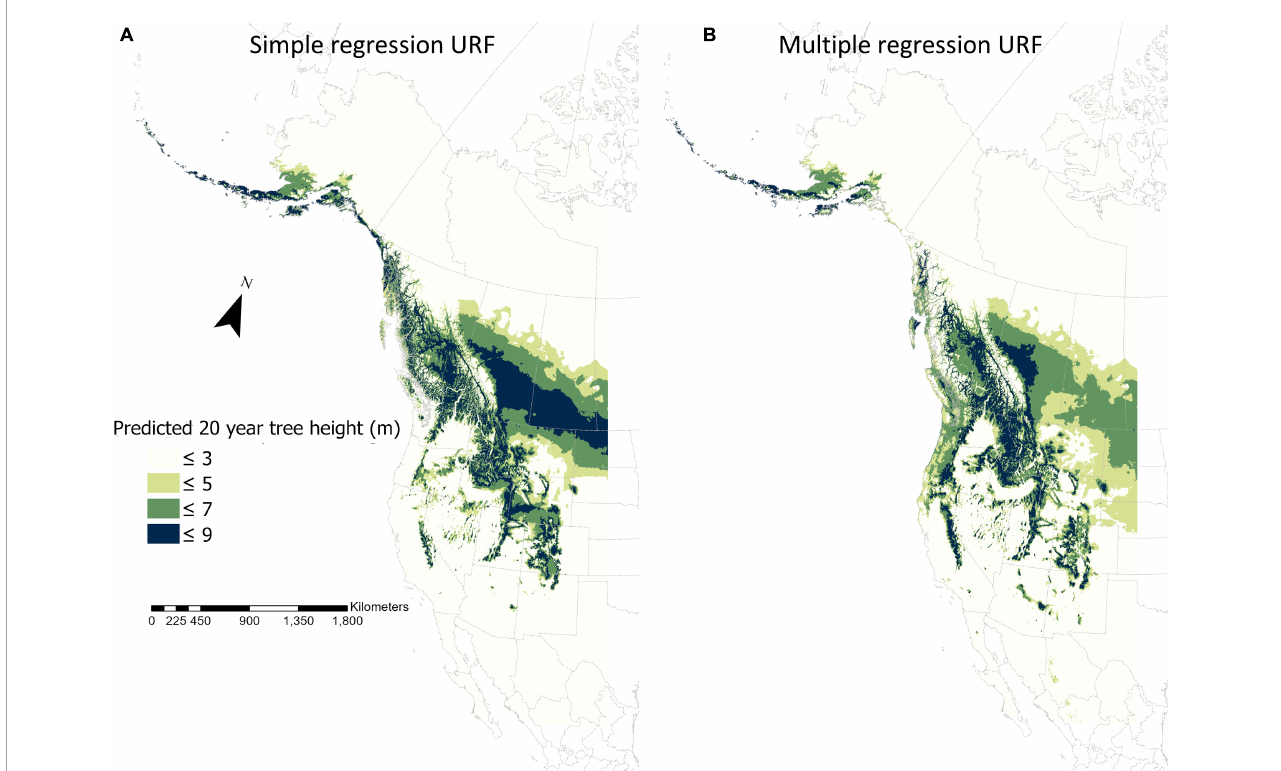
FIGURE3 Spatial distributions of the fundamental climate niche of lodgepole pine ( Pinus contorta ) in Western North America in current climate predicted by a simple regression universal response function (A) and the final universal response function with multiple variables (B) . The spatial resolution is 4 × 4 km. The climate variables for the simple regression and the final universal response functions are listed in column of “URF” in Table 1 and column “URF” in Table 2 ,